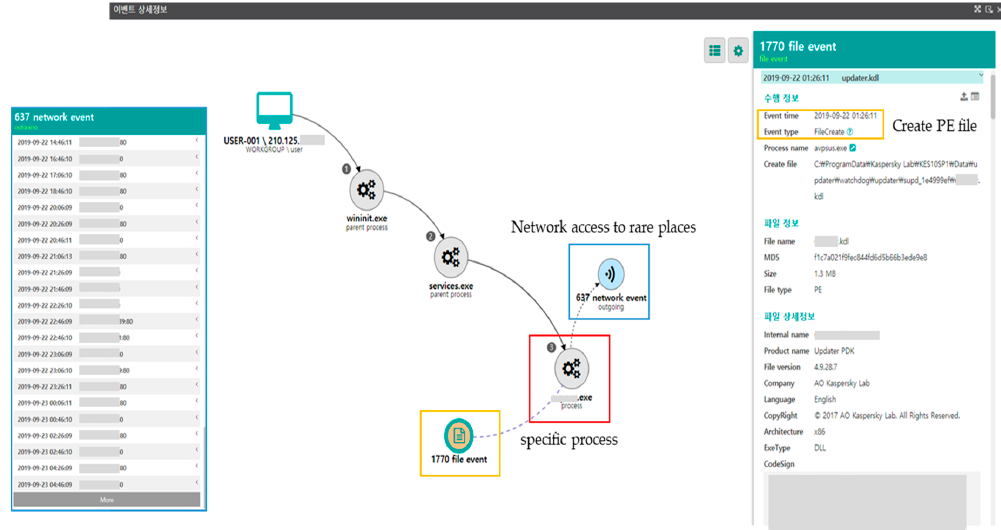
19 of 21 Figure A1. Attack Profile Scenarios for suspected malware download.